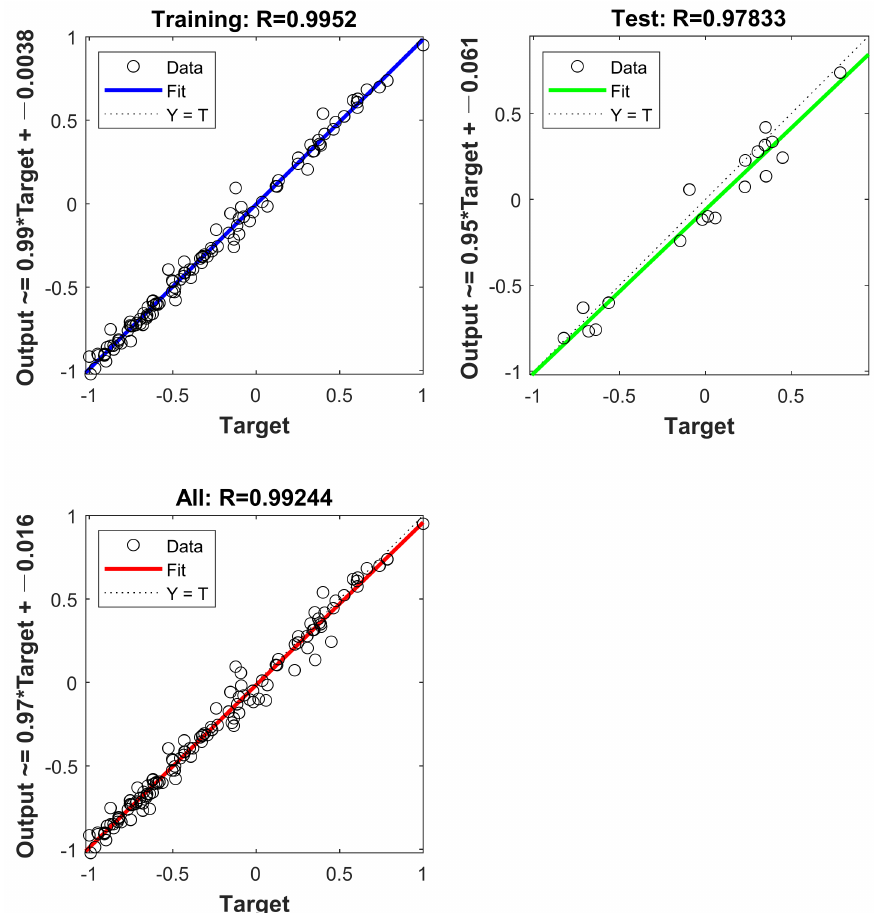
Figure 12. AO-BR model